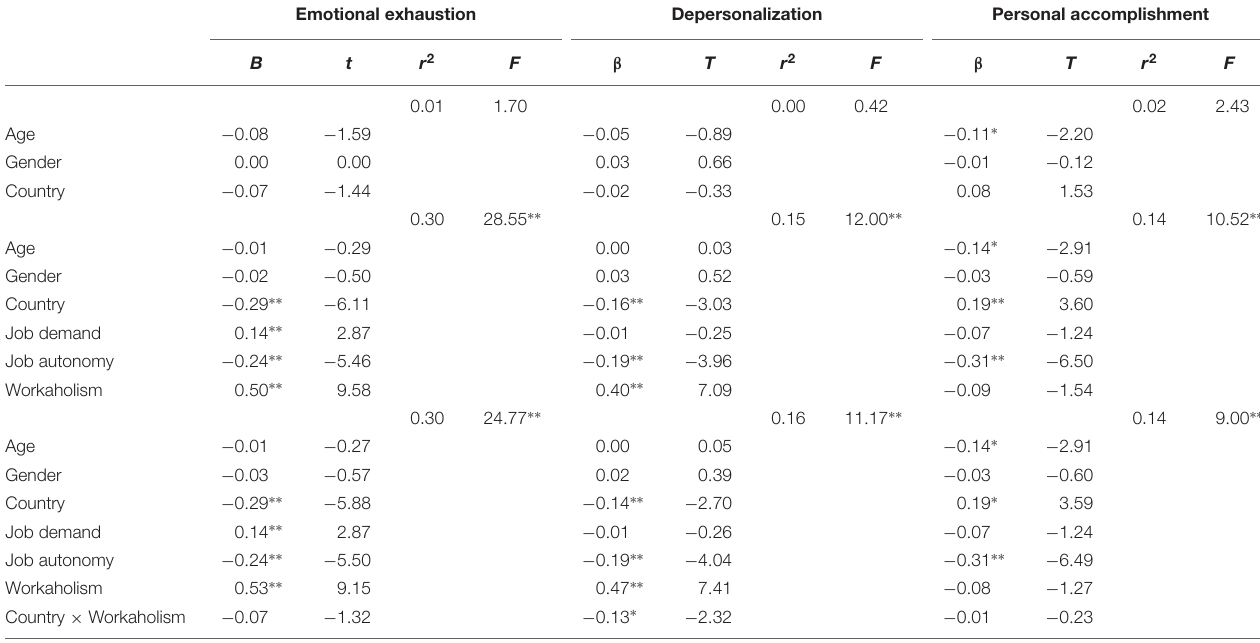
TABLE 7 | Moderated regression analysis for manufacturing industry.